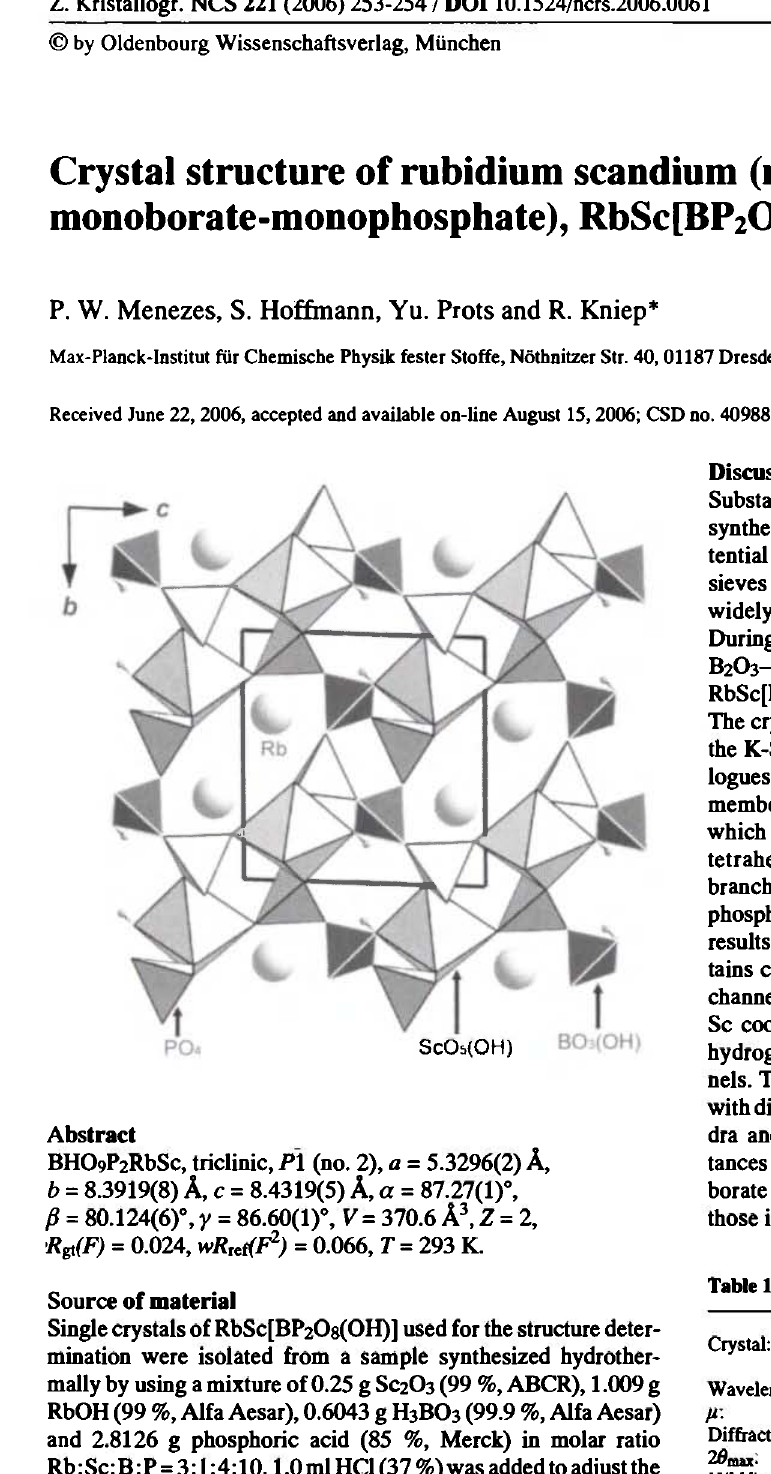
Table 2. Atomic coordinates and displacement parameters (in Ä 2